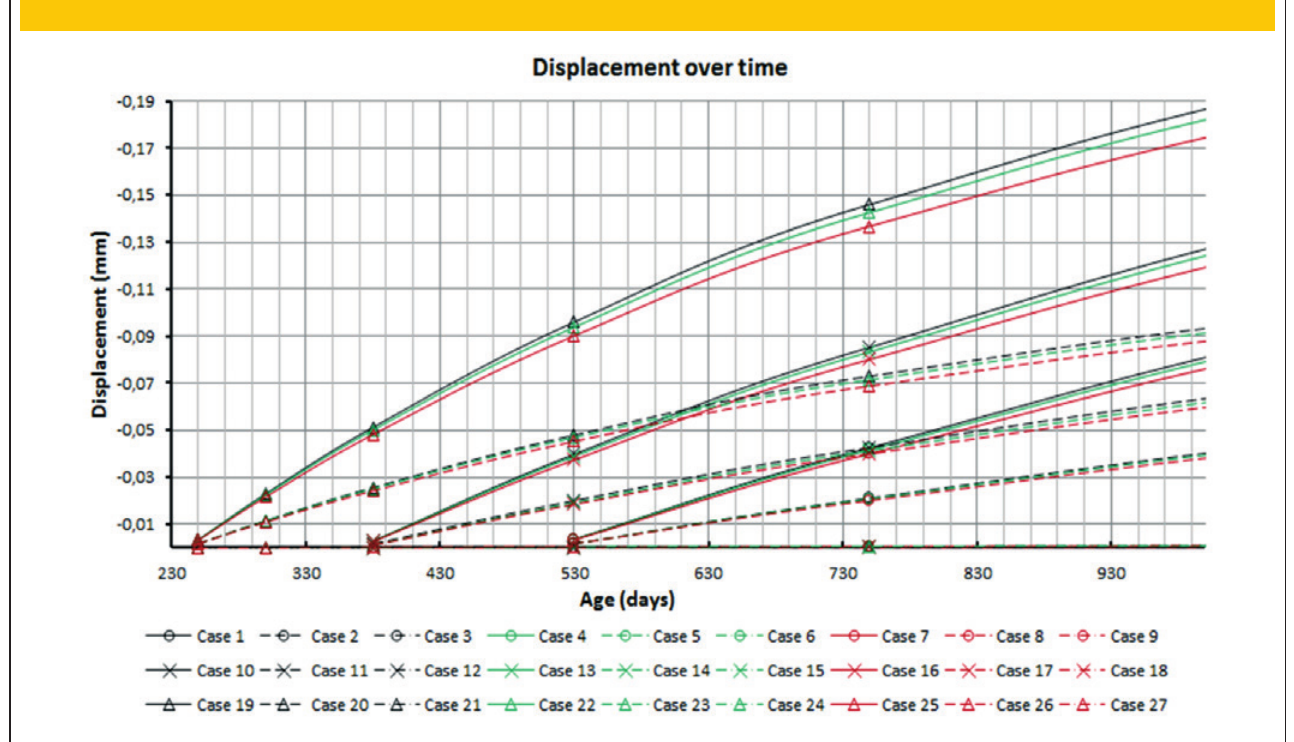
Figure 10 – The concrete solid mass displacements initiation on the "x" direction due to